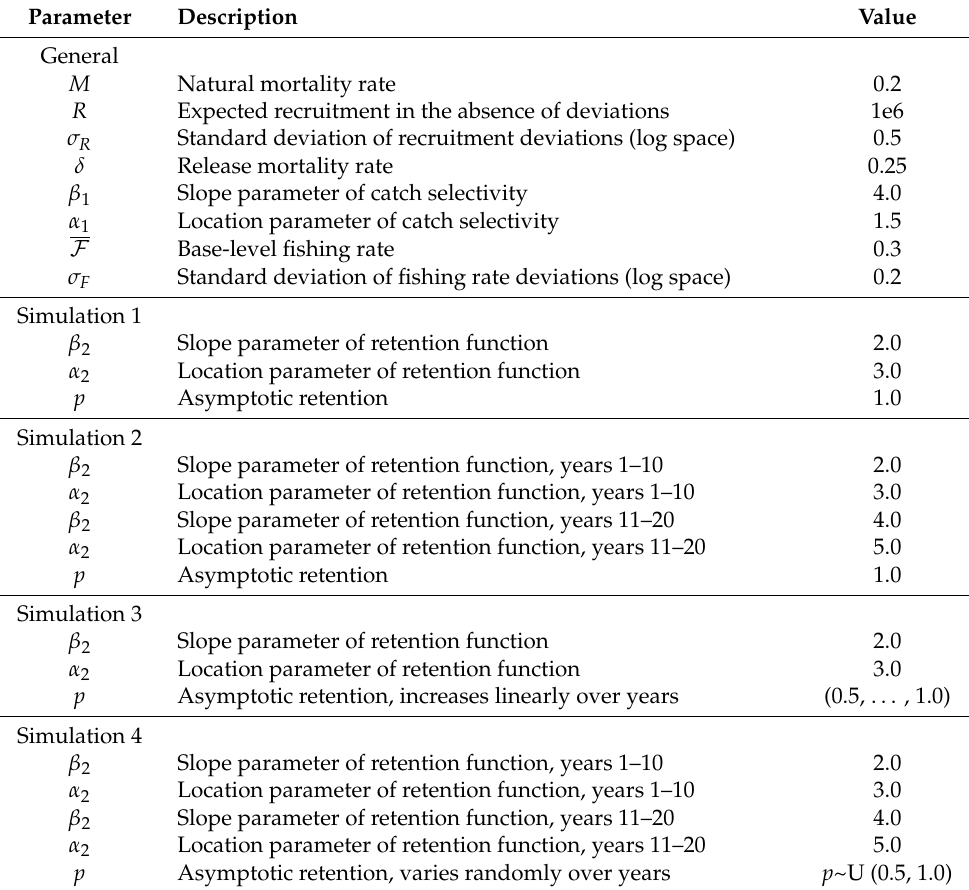
Table 1. Parameters of simulation